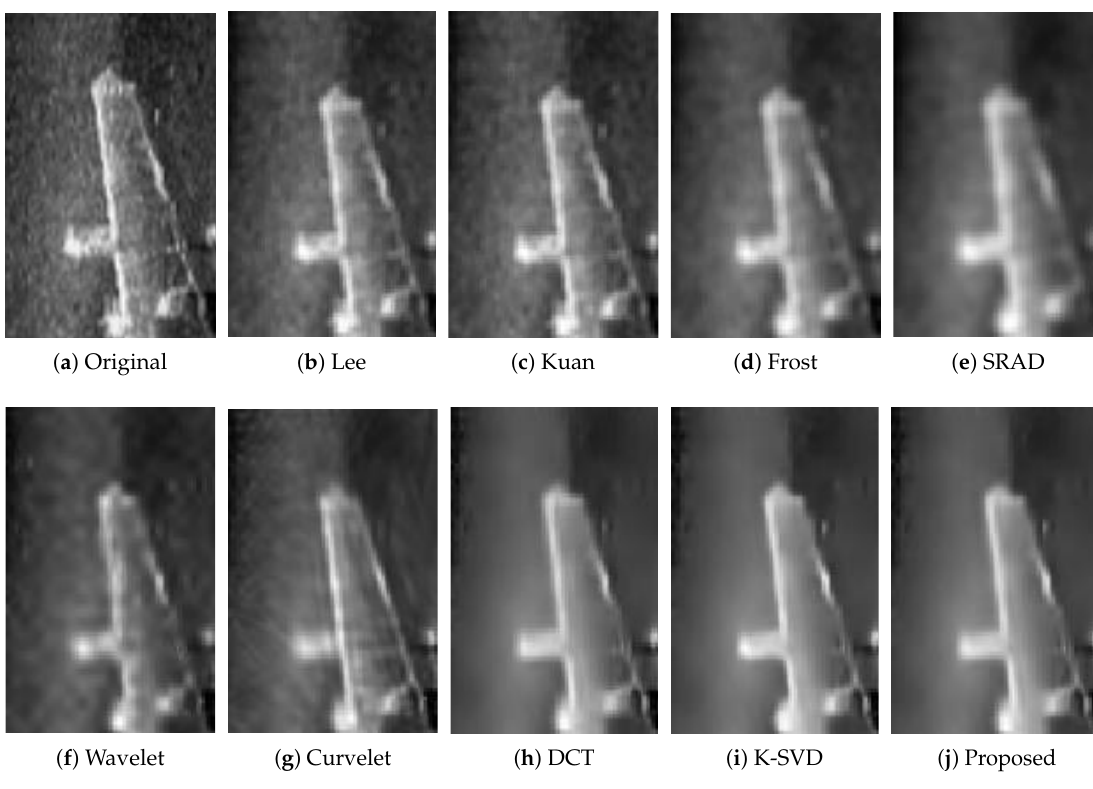
Figure 10. The details of Figure